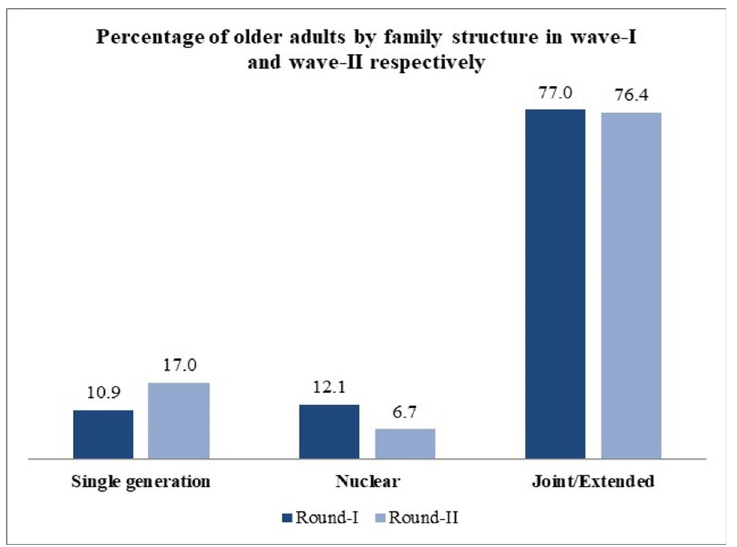
Fig 2. Distribution of older adults by their family structure during waves -I